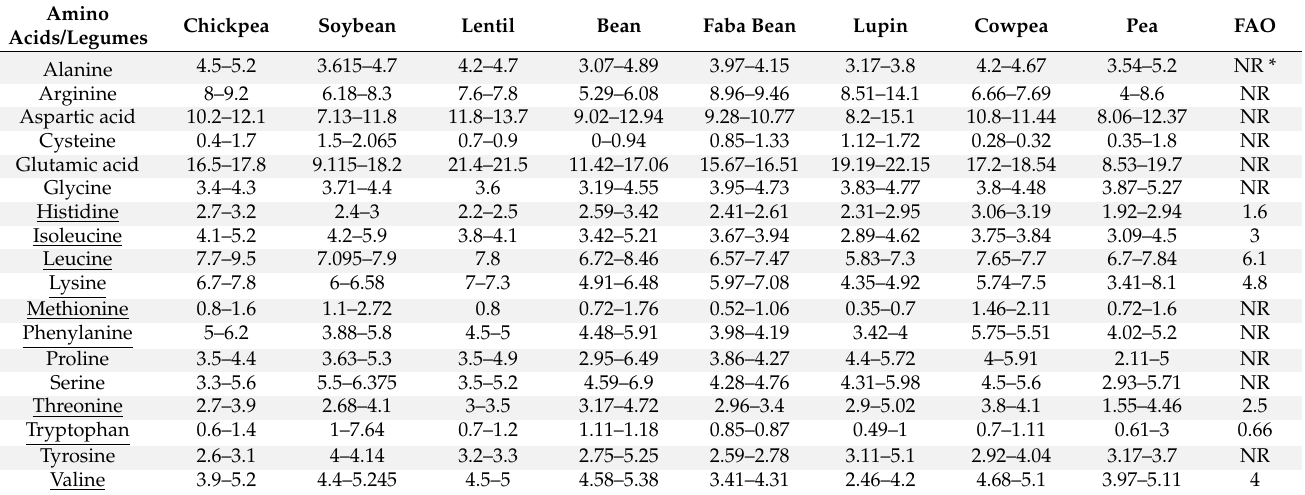
Table 1. Amino acid content of various legumes and the recommended amino acid scoring patterns for adults (g/100 g protein)